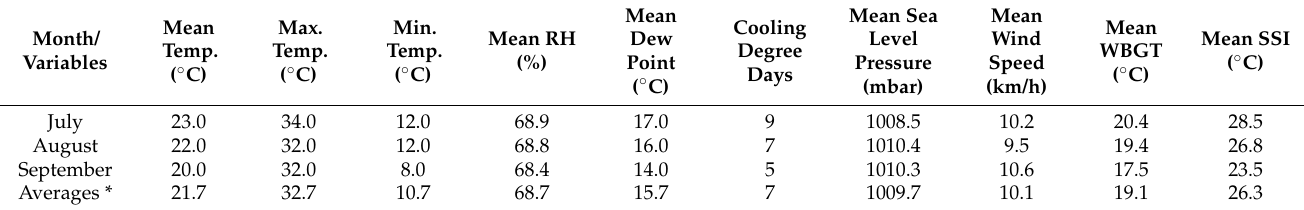
Figure 3. Comparison of the averages of maximum, minimum, and mean temperatures for the out ‐ door weather conditions during the warmest months between 2016 and 2017. 3. Results The estimation of the average number of hours spent indoors daily revealed that about 88% of the time was spent indoors per day. More than two ‐ thirds of the respondents are female. During the surveys, most of the participants were either working from home, working night shifts, or on summer vacation. These findings may contribute to the esti ‐ mated higher number of hours spent indoors per day in the case studies. The result con ‐ forms to the finding from existing research in the field that on average, people in the de ‐ veloped nation, particularly in the United States (the location of the field surveys) spent close to 90% of their time indoors daily [38]. The average sensation value of 3.25 (where 1 signifies cold, 0 stands for neutral, and 7 stands for hot) was computed during the comfort surveys. Only 10% of the residents noted that they feel “warm” or “hot” within the ther ‐ mal environment. Approximately 79% of the respondents prefer to be “cooler” or “no change” within the thermal environment. Additionally, about 67% of the occupants are thermally comfortable within the indoor spaces of the case study buildings (Table 3).